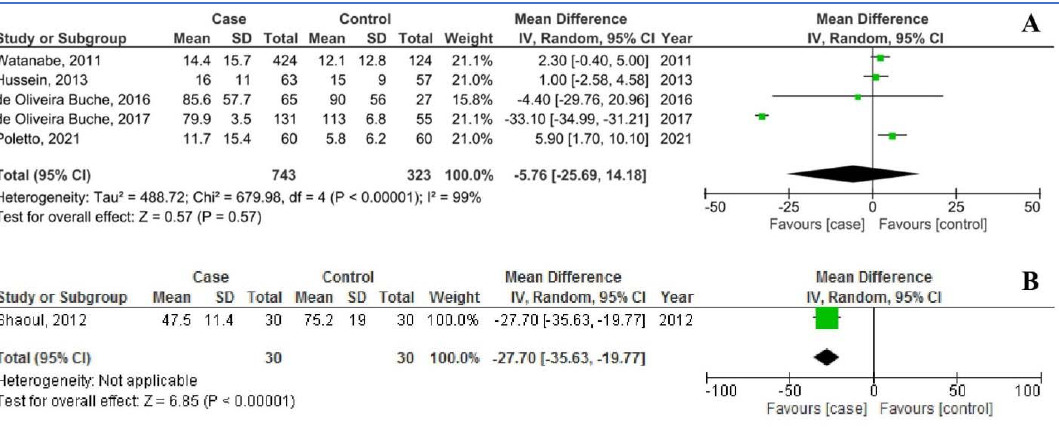
Figure 2. Pooled analysis of salivary iron ( A ) and serum iron ( B ) levels in the participants with dental caries (cases) compared to those without caries (controls). Abbreviations: SD, Standard Deviation; IV, Inverse Variance; CI, Confidence Interval.